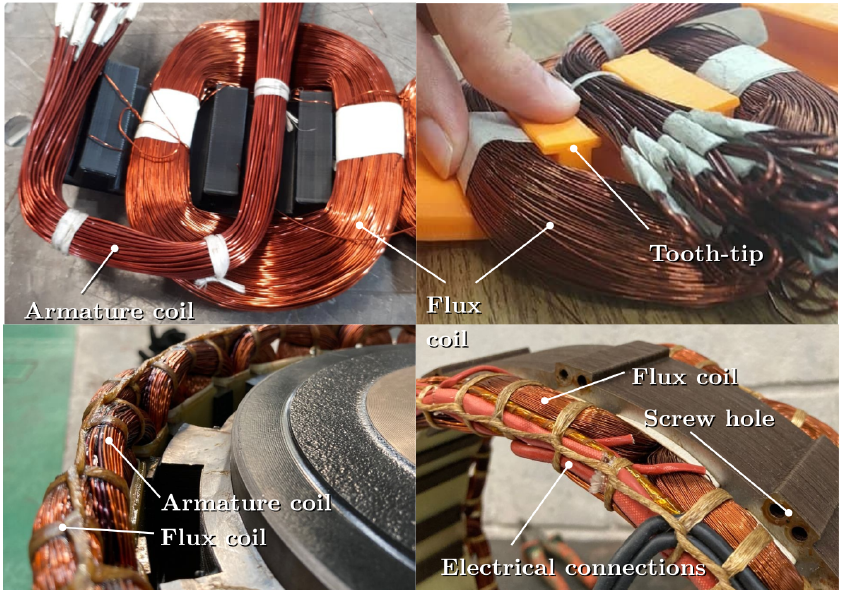
Figure 3. Manufacturing evaluation using a 3D-printed model, and final result in the built